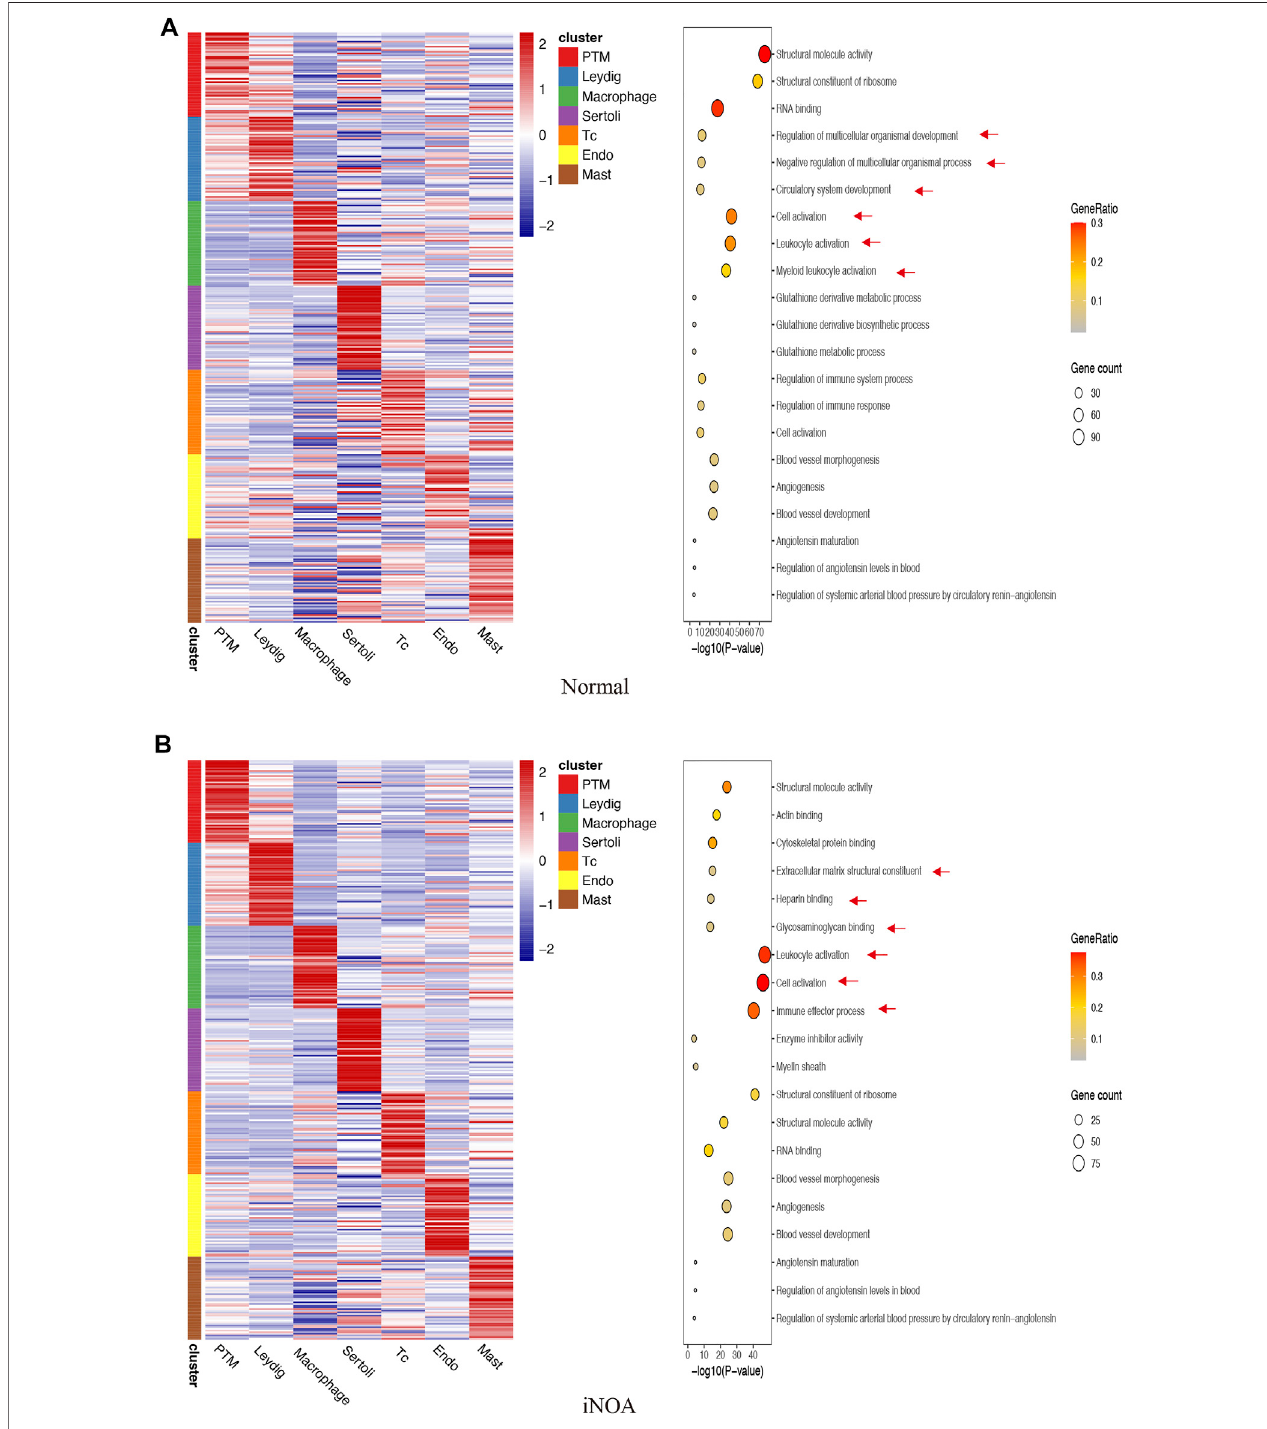
FIGURE 2 | Gene Ontology (GO) enrichment analysis of marker genes in (A) the normal group and (B) the idiopathic non-obstructive azoospermia (iNOA) group. Left: heatmap showing expression signatures of the top 50 speci fi cally expressed genes in each cell type; the value for each gene is the row-scaled Z score. Right: representative GO